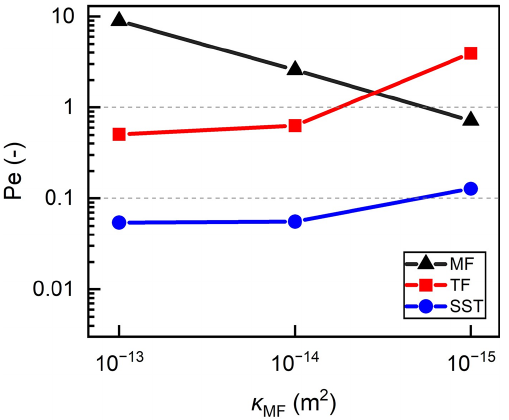
Figure 6. Effects of the main fault permeability ( κ MF ) on the Pe (median Peclet numbers) of the main fault (MF), transfer faults (TF) and sandstone (SST).